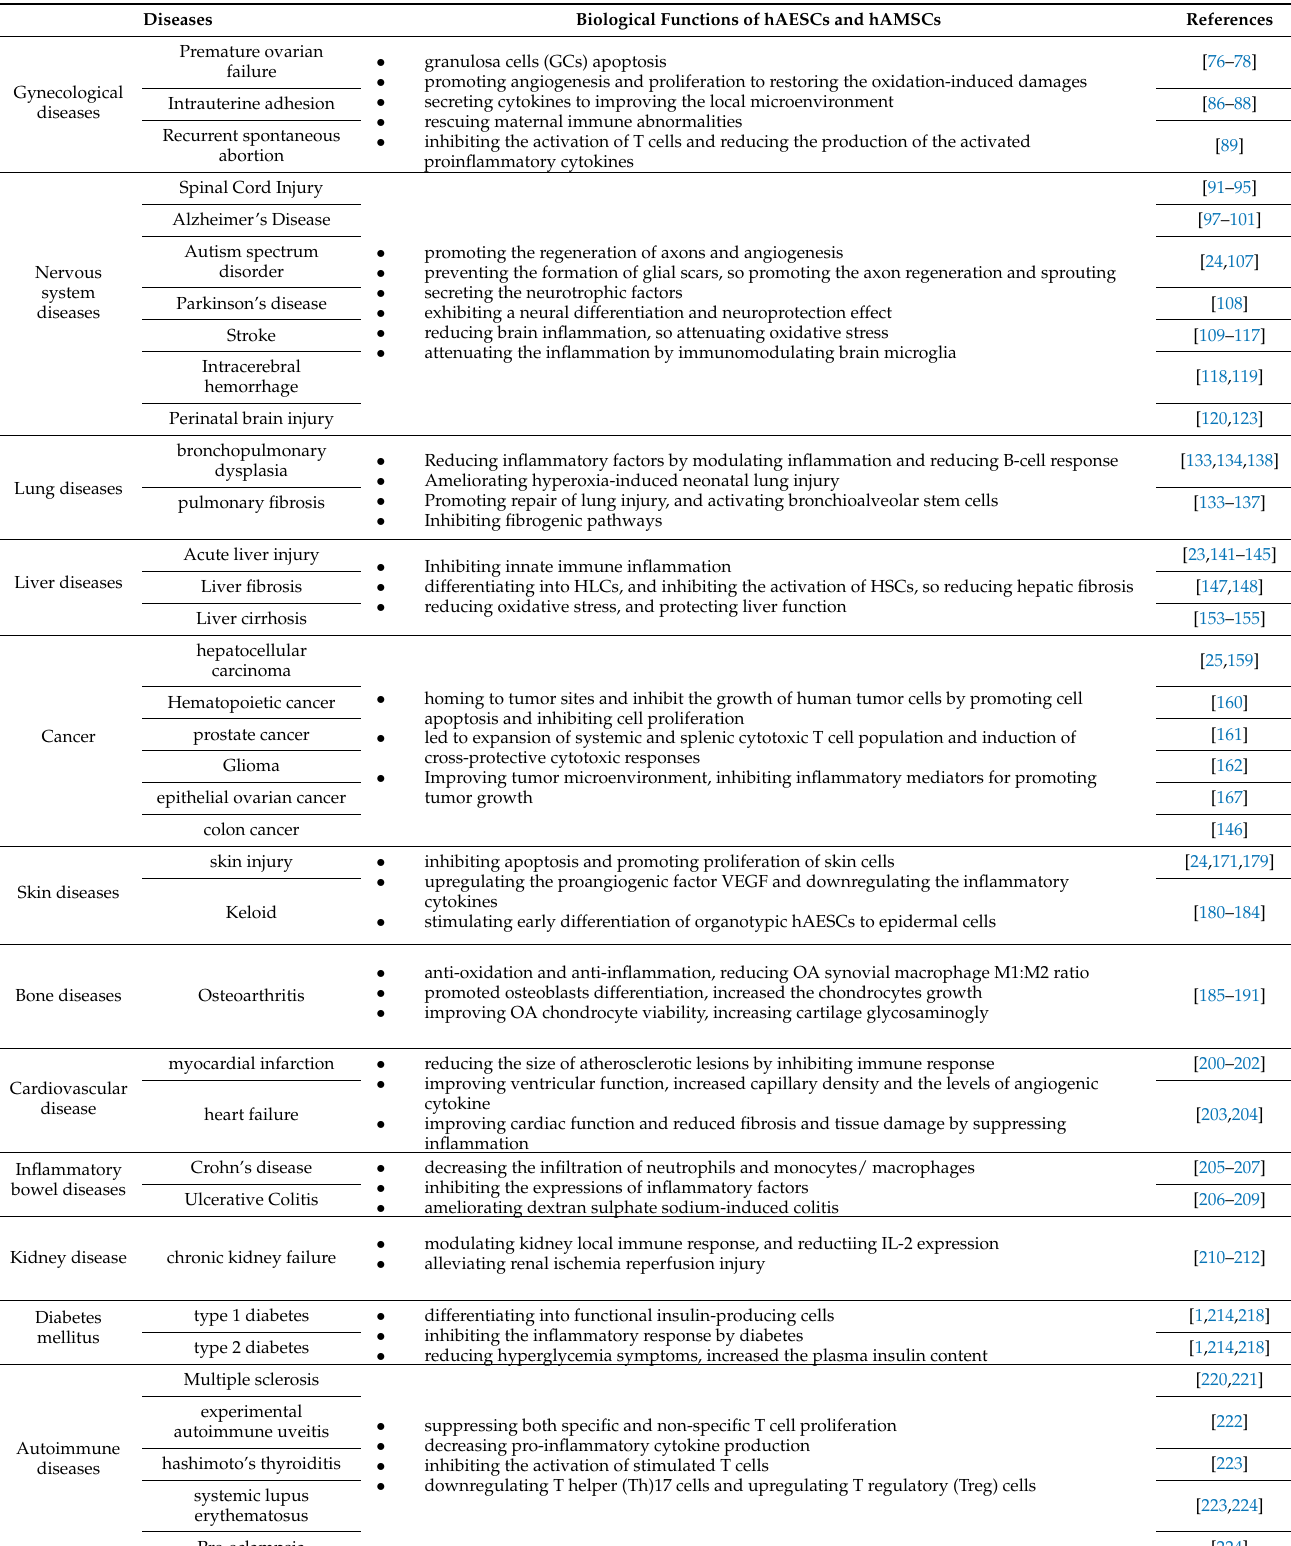
Table 3. Biological functions of hAMSCs and hAESCs in various